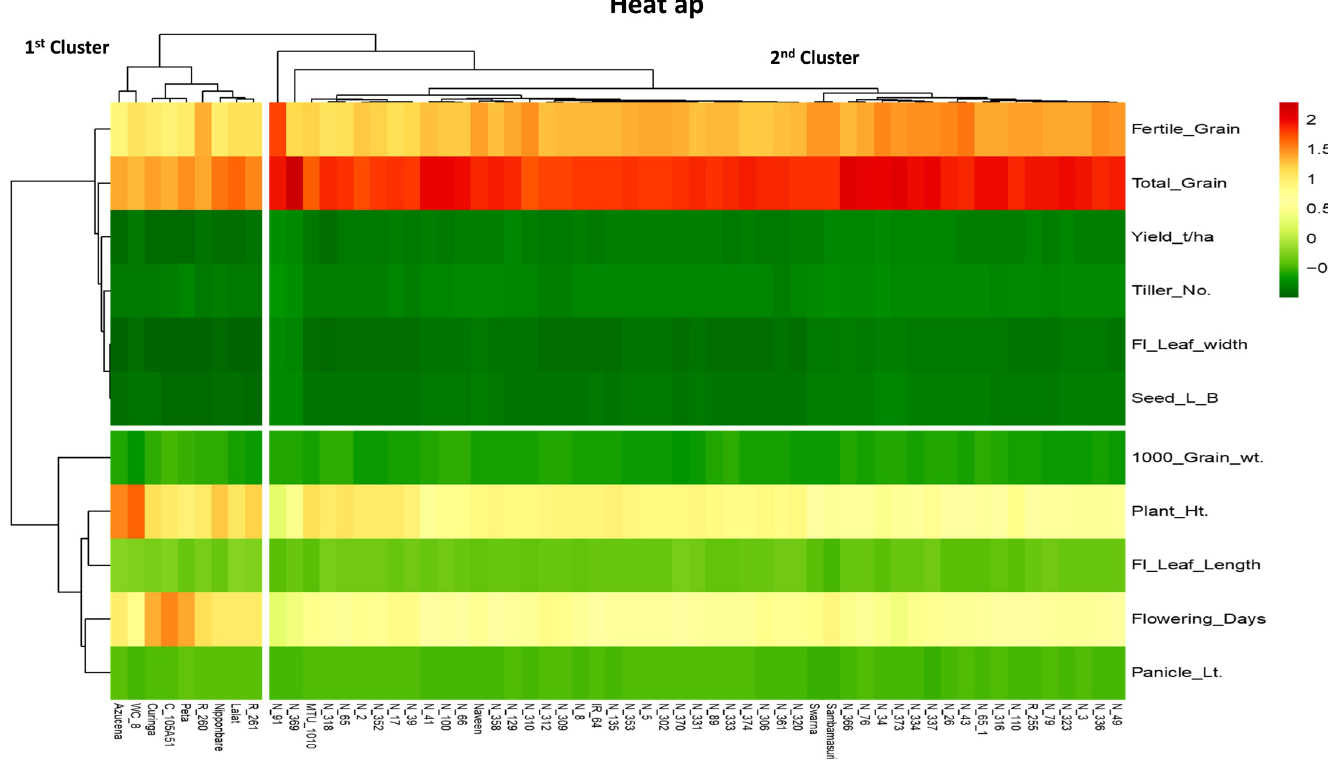
Fig 3. Heat Map showing that both genotypes and traits are grouped into rows and columns by using correlation distance and average matrix.